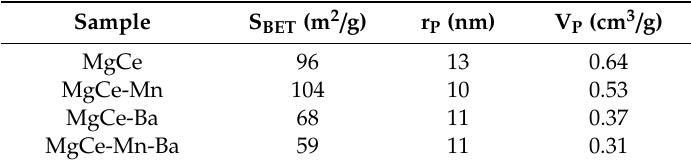
Table 2. Physical properties of the samples studied in this work.